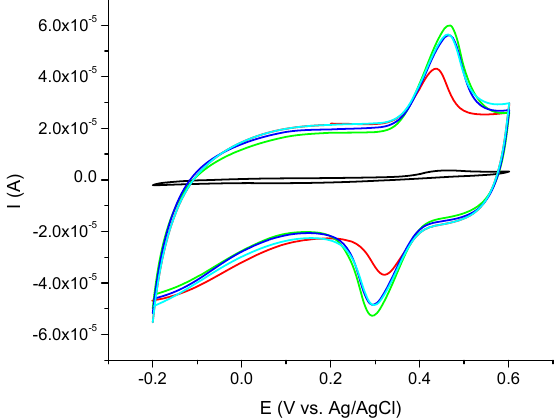
Figure 3. Cyclic voltammetry of nanocomposite MWCNT (type 1)/Ppy film permeability on SPE tested in the presence of 10 − 4 M acetaminophen in 0.1 M LiClO4, 10 cycles (red), 20 cycles (green), 40 cycles (blue), 60 cycles (cyan) compared with unmodified GCE 5 cycles